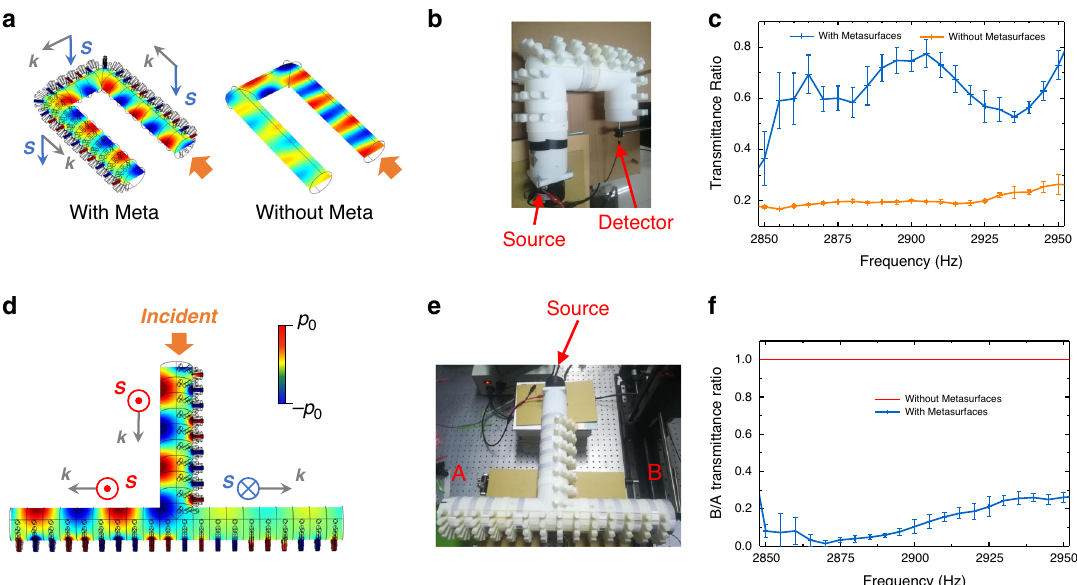
Fig. 5 Acoustic SAM-induced robustness on wave transport and SAM-related wave routing. a The robustness can be re fl ected by the transmittance ratios of waveguides with/without metasurfaces to the unperturbed straight ones. The pressure fi elds are plotted in the normalized color bar. b The experimental settings. The source excites the waveguide modes and the pressure fi elds are measured by the detectors. The transmittance ratios are obtained by calculating the ratio between the U-shape waveguide and straight waveguide with the same length. c The experimental results show that the nonzero SAM of acoustic modes and the associated tight spin-momentum coupling will enhance the backscattering suppression. d The acoustic wave will selectively propagate along one side due to the SAM match when facing multiple channels. Reversing the incident acoustic wave spin will change outgoing waves to select the other channel with opposite spin. This acoustic spin-selective directionality is reminiscent of the spin-Hall-like effects for electrons and optics. e The experimental results to demonstrate the selective transport based on the matched SAM. The pressure fi eld strengths at the port A and B are recorded. And the ratio between the port A and B will re fl ect this SAM-based selectivity. f The experimental results (blue line) show the strong selective phenomena. The red line means that the wave transport is divided equally in the normal T-waveguide without metasurfaces, namely A = B (B). At the crossing point, the SAM of modes will make the acoustic wave propagate along the direction with the matched SAM. Moreover, it shows that this spin-selective transport will also be insensitive to the backscattering at T corner, due to the modes and the assistance of spin-momentum locking.